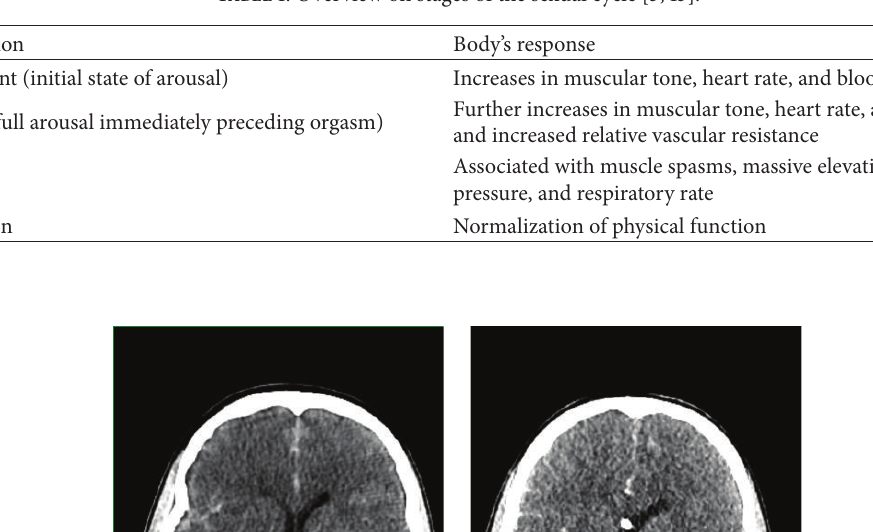
Table 1: Overview on stages of the sexual cycle [3, 13].